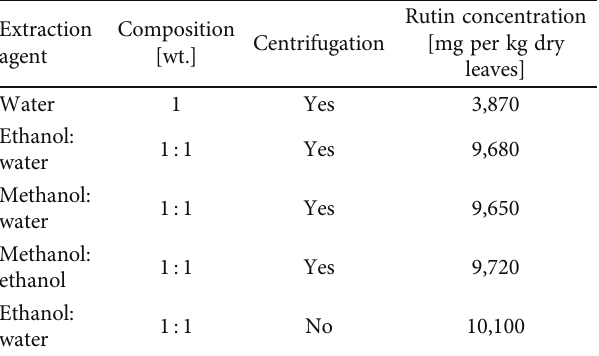
Figure 1: Rutin trihydrate used as standard. Table 1: Overview of extraction agents, extraction process, and rutin concentrations